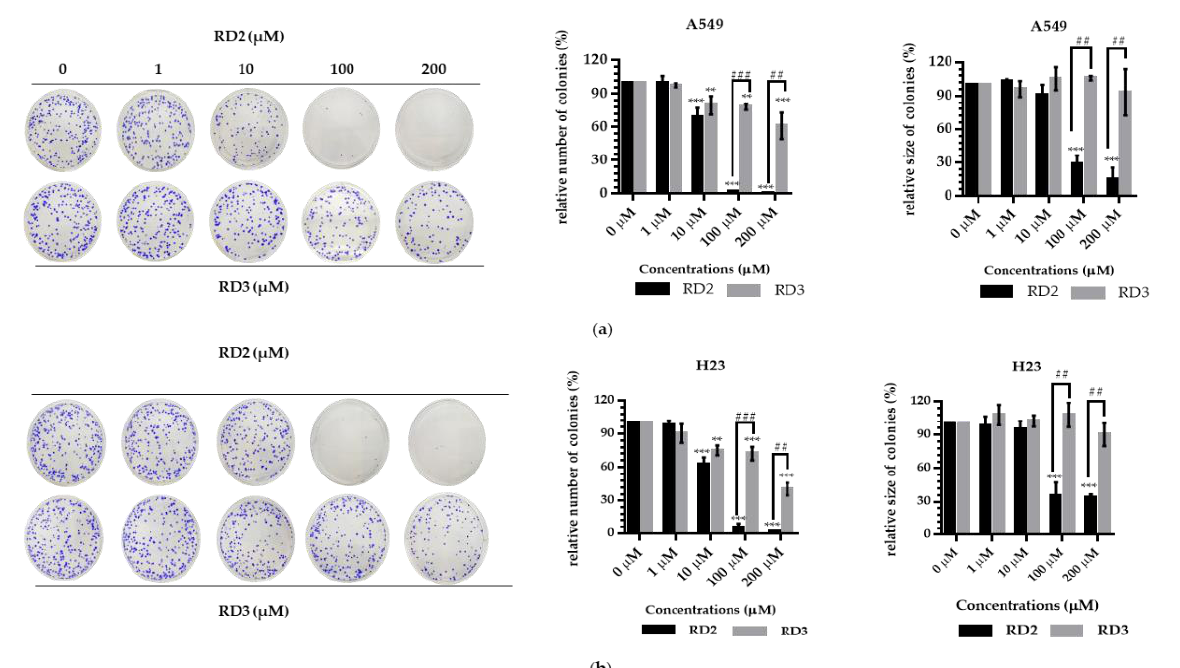
Figure 3. Resveratrol derivatives inhibit colony formation activity and induce apoptosis in NSCLC cells (A549 and H23). ( a , b ) Cells were treated with RD2 and RD3 (0–200 µ M for 24 h). After 1 week, colonies were stained with 1.25% crystal violet and quantified by extraction with 10% acetic acid and the analysis are determined by number and size of colony cancer cell. Data are represented as the mean ± SEM ( n = 3). * p < 0.05, ** p < 0.01, *** p < 0.001 when compared with the control group. # p < 0.05, ## p < 0.01, ### p < 0.001 when compared between RD2 and RD3.